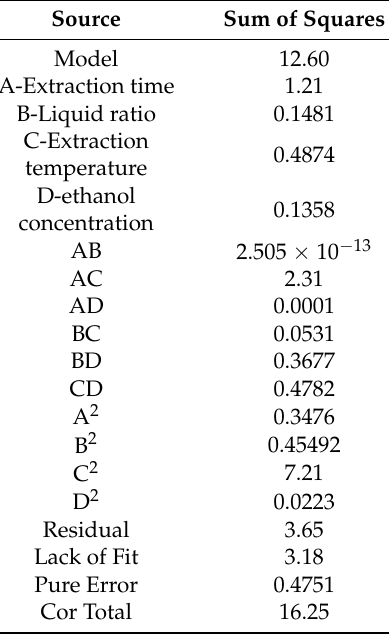
Table 2. Variance analysis table of flavonoid absorbance of cotton flowers optimized by Response Surface